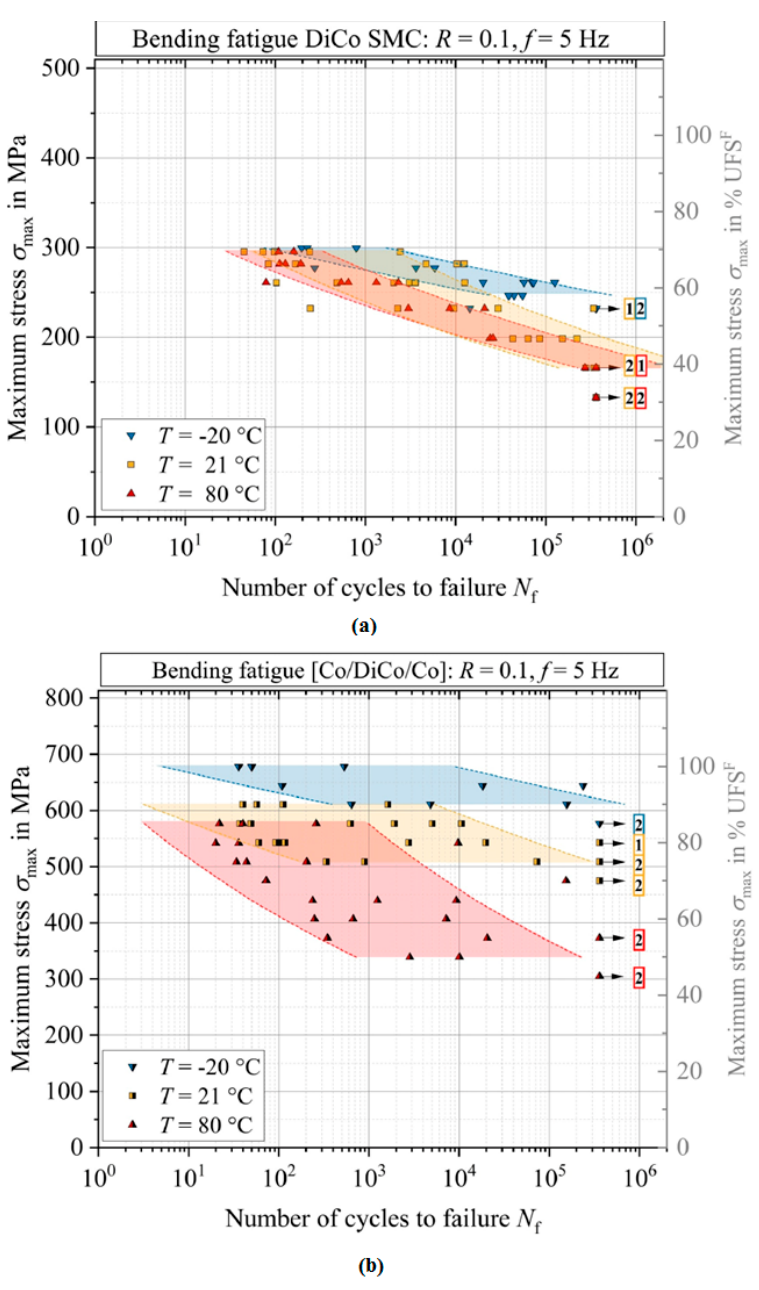
Figure 47. S-N data for ( a ) DGF-reinforced SMC composite specimens and ( b ) hybrid [UCCF/DGF/UCCF] SMC specimens under 3-point bending fatigue load at different temperatures for failure probabilities of PS = 10% and PS = 90% [17].